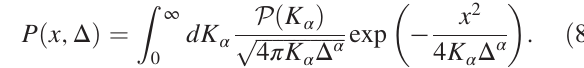
Fig. 10. The inert atoms, otherwise displaying